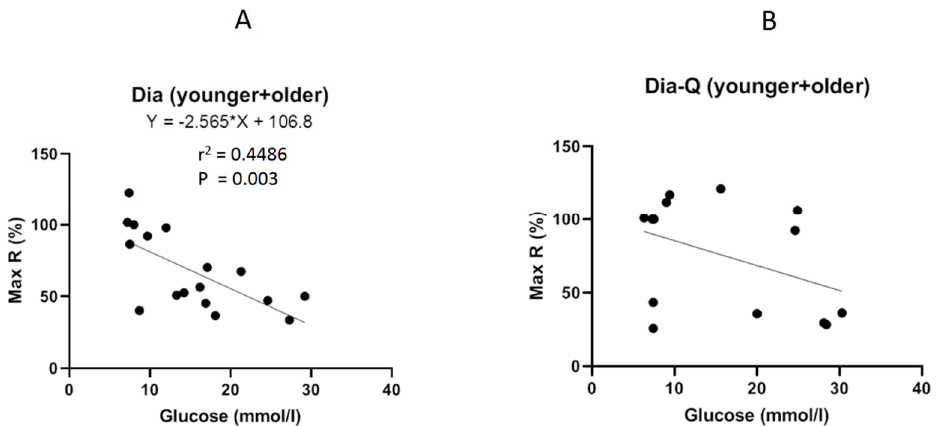
Figure 4. Correlations between maximal relaxation and glycaemia. The mutual relationship between maximal vasorelaxation induced by acetylcholine in thoracic aorta and plasma glucose level in rats without ( A ) and with ( B ) the treatment with quercetin. Max R = maximal relaxation.